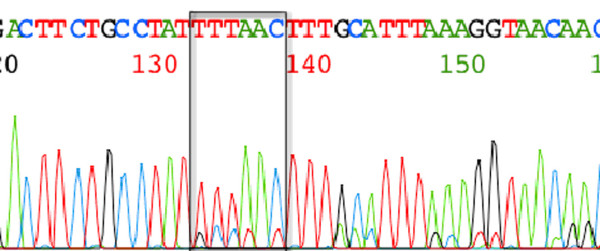
Electrophergram of the mid portion of exon 9 of KIT from this patient's GIST showing two alleles, one with a 6 bp tandem repeat insertion (GCCTAT) leading to a duplication of amino acids alanine and tyrosine at codons 502 and 503 (enclosed in the square).